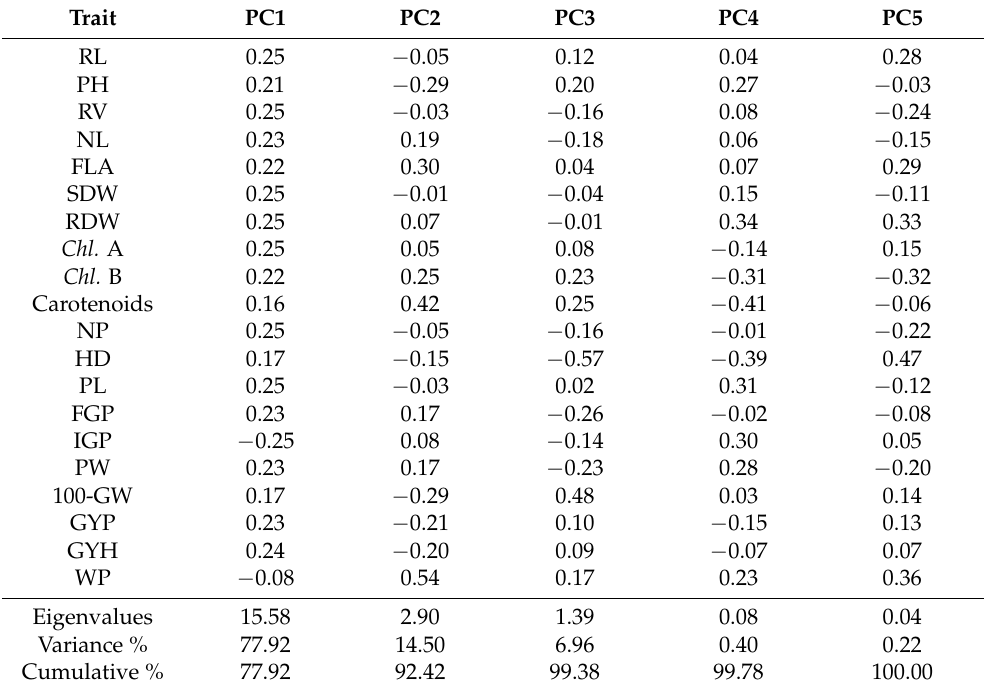
Table 8. Results of the principal component analyses (PCAs) in the first five PCs for the studied traits during the main effects of experimental factors. Trait